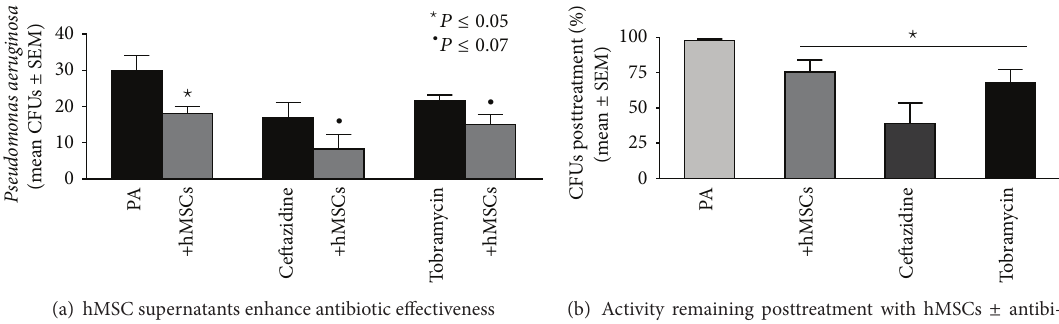
Figure 5: Antibiotic enhancing activity. To determine whether the antibiotic enhancing effects of the bone marrow derived hMSCs were antibiotic specific, we tested the ability of the hMSCs to enhance the impact of other antibiotics which are often used to treat CF: ceftazadine (100 𝜇 g/mL) and tobramycin (100 𝜇 g/mL). (a) Ceftazadine and tobramycin decreased Pseudomonas aeruginosa CFUs ( 𝑃 ≤ 0.05 , 𝑛 = 3 ) which were enhanced by the addition of hMSCs derived supernatants ( 𝑃 = 0.06 for ceftazadine and 𝑃 = 0.07 for tobramycin). (b) When each experiment is used as its own control for Pseudomonas aeruginosa growth (100%), the MSCs and the antibiotics had statistically significant effect on Pseudomonas growth (100 𝜇 g/mL, 𝑃 ≤ 0.05 ).